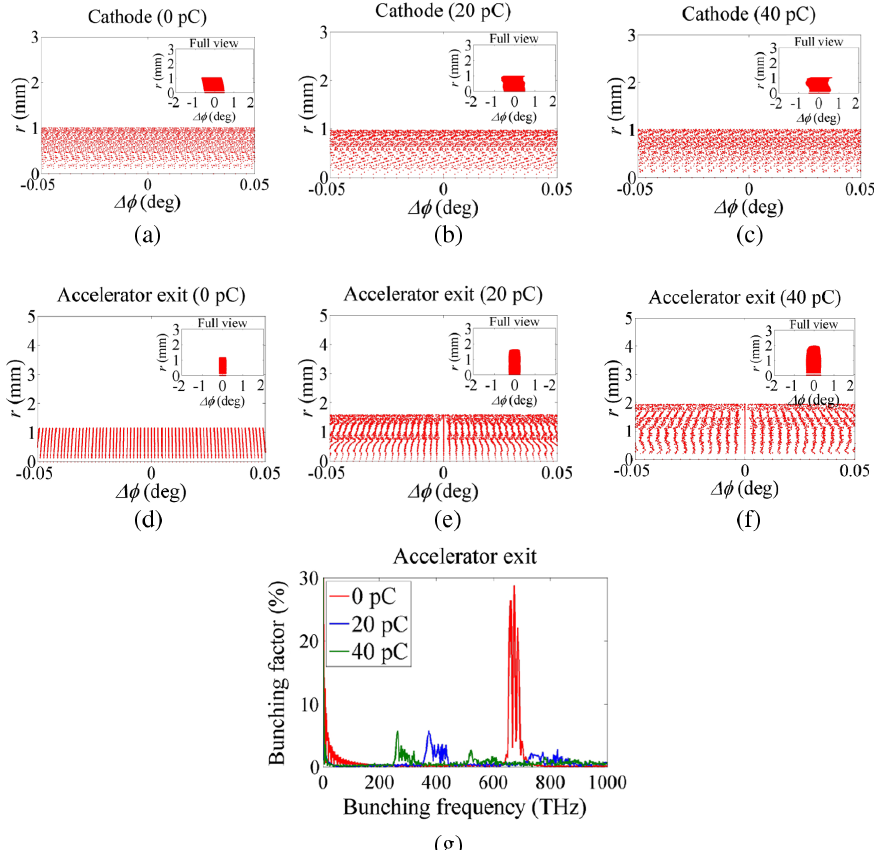
FIG. 10. (a) – (c) Initial Δ ϕ − r distributions of particles for the partially phase compensated electron-pulse trains containing total charges of 0, 20, and 40 pC at the cathode, respectively. (d) – (f) Δ ϕ − r distributions of the accelerated electron-pulse trains at the exit of the accelerator with inputs in (a) – (c), respectively. (a) – (c) are generated through photoemission of electrons from a train of identical driver laser pulses incident on the cathode with the pulse front of the central laser pulse optimized to generate a delta-function bunch at the pulse-train center after acceleration. (g) Bunching spectra of the partially phase compensated electron-pulse trains at the exit of the accelerator, indicating deterioration of electron bunches from the acceleration and space charge